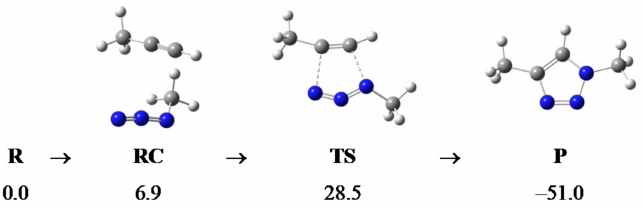
Figure 3. The uncatalyzed direct conversion of alkyne m1 0 and azide m2 into triazole. Relative Gibbs free energies for isolated reactants (R), reactant complex (RC), transition state (TS) and isolated product (P) correspond to the DMF solution (in kcal mol − 1